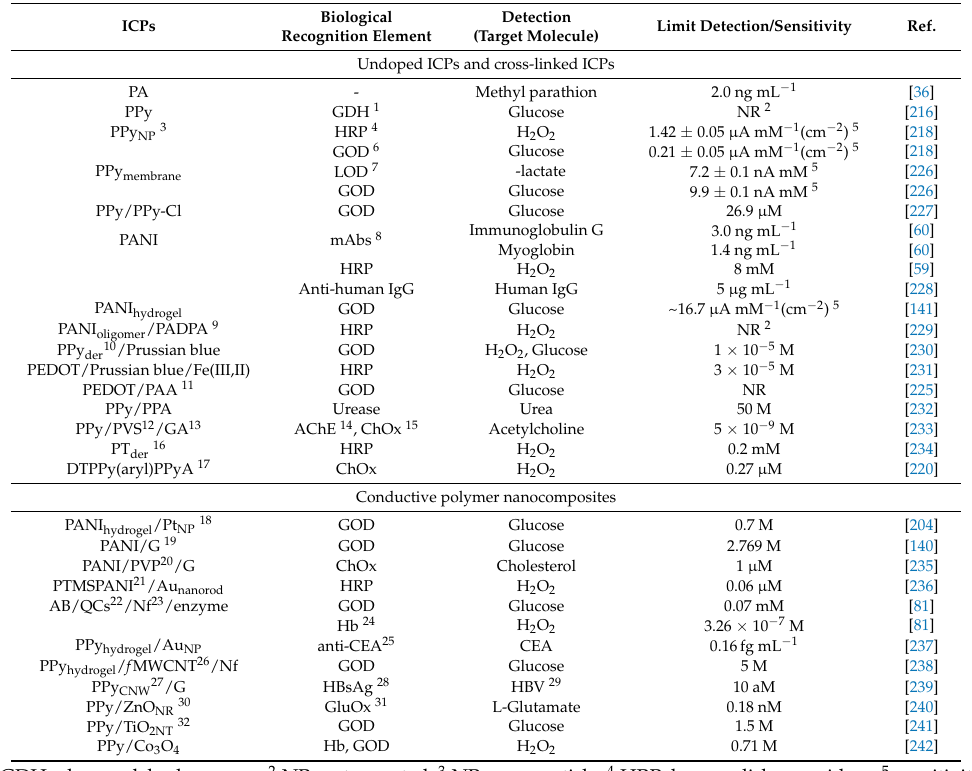
Table 3. Some examples of biosensors and electrochemical sensors containing